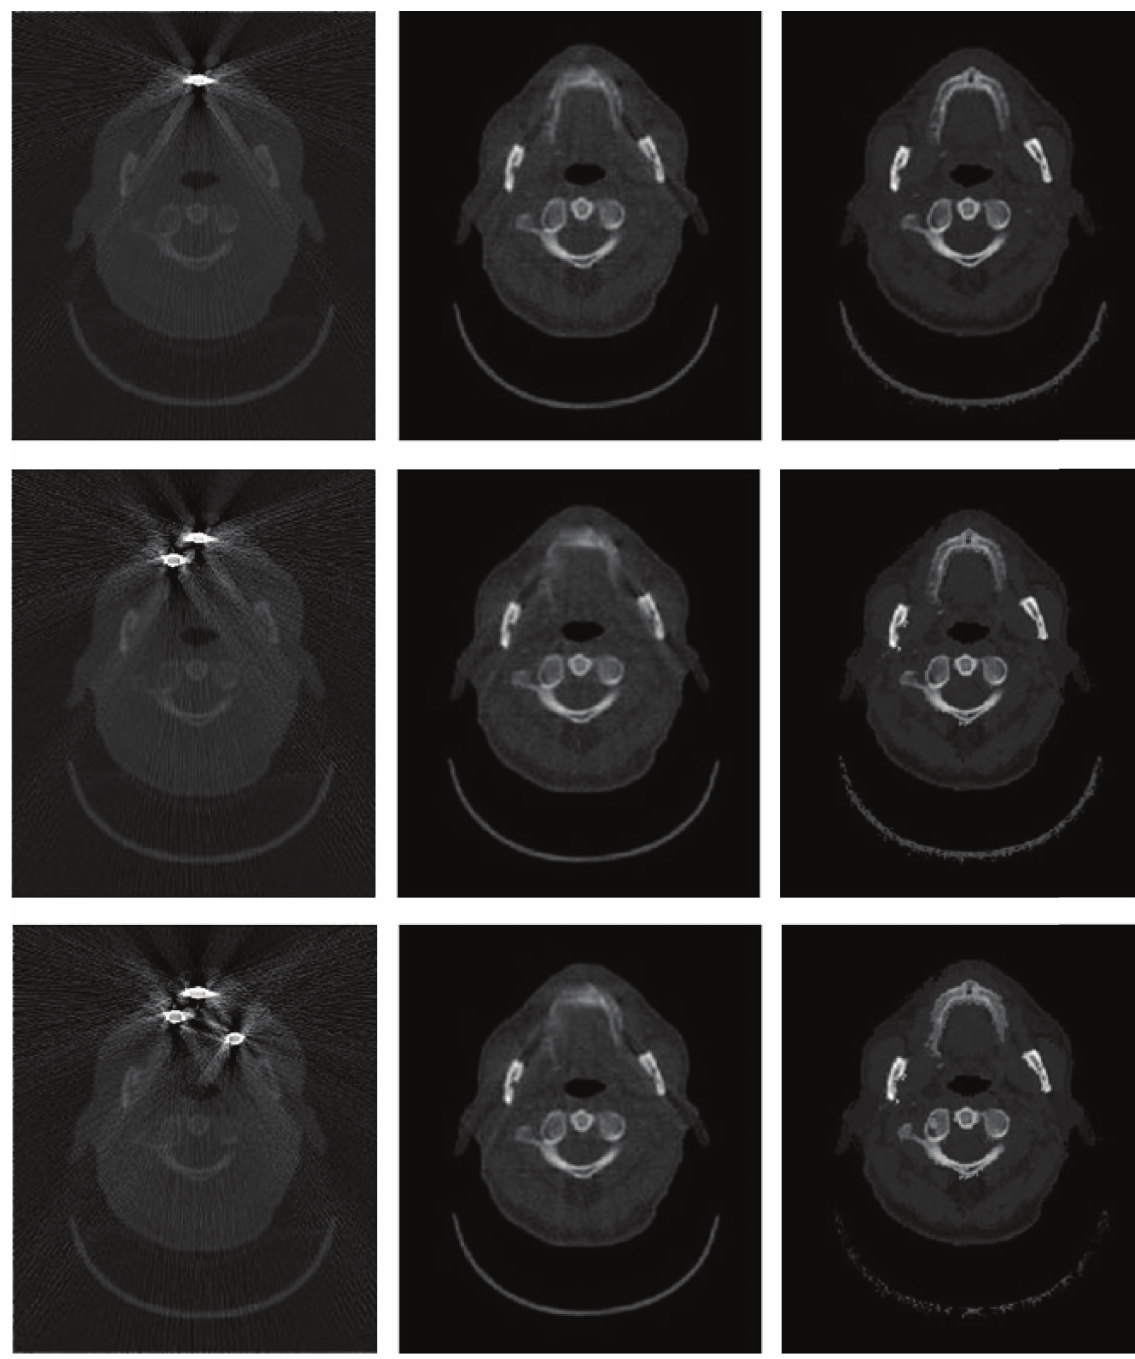
Figure 5: Axial view of CT dataset with simulated implants is in the first column, the second column shows the results obtained with linear interpolation method, and the results of the proposed method are presented in the last